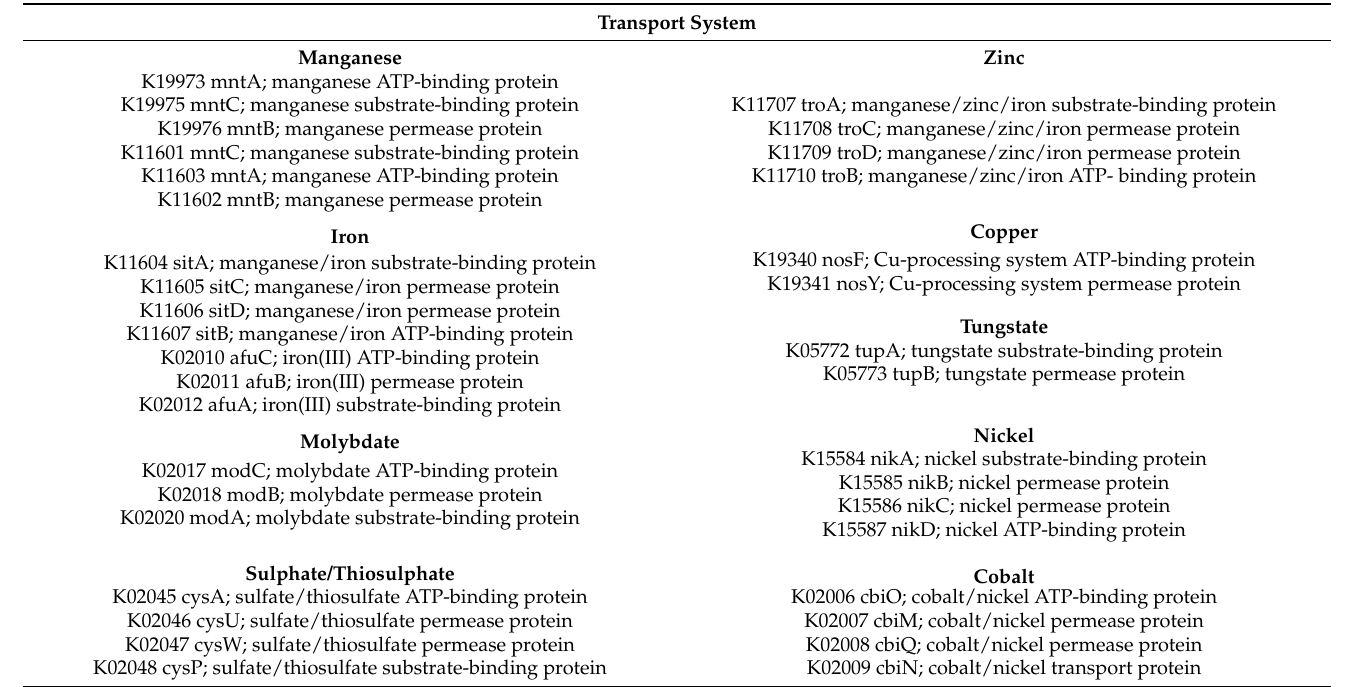
Table 1. Differentially abundant transporters required for heavy metal resistance in hot springs